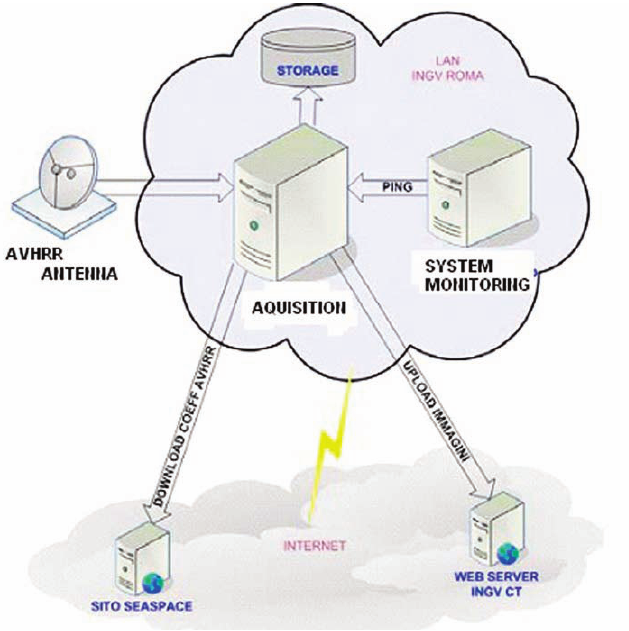
Figure 2. AVHRR data acquisition